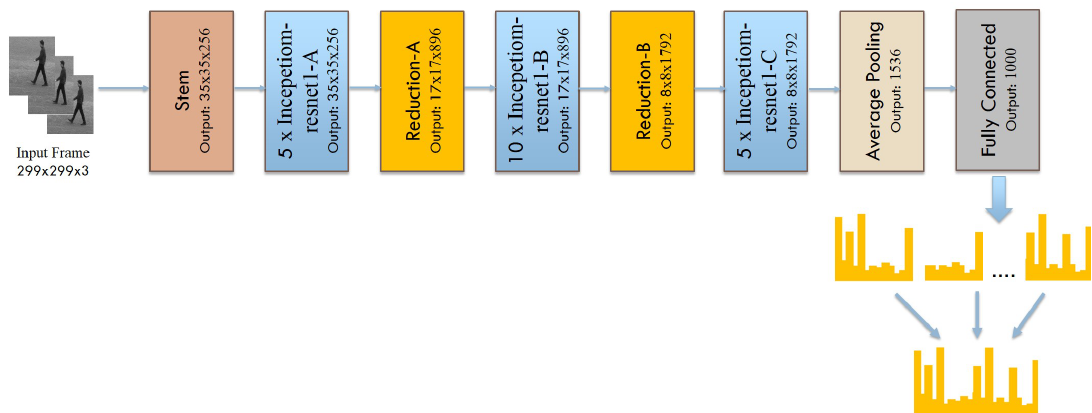
Figure 2. Deep spatial feature extraction using the Inception-Resnet-v2